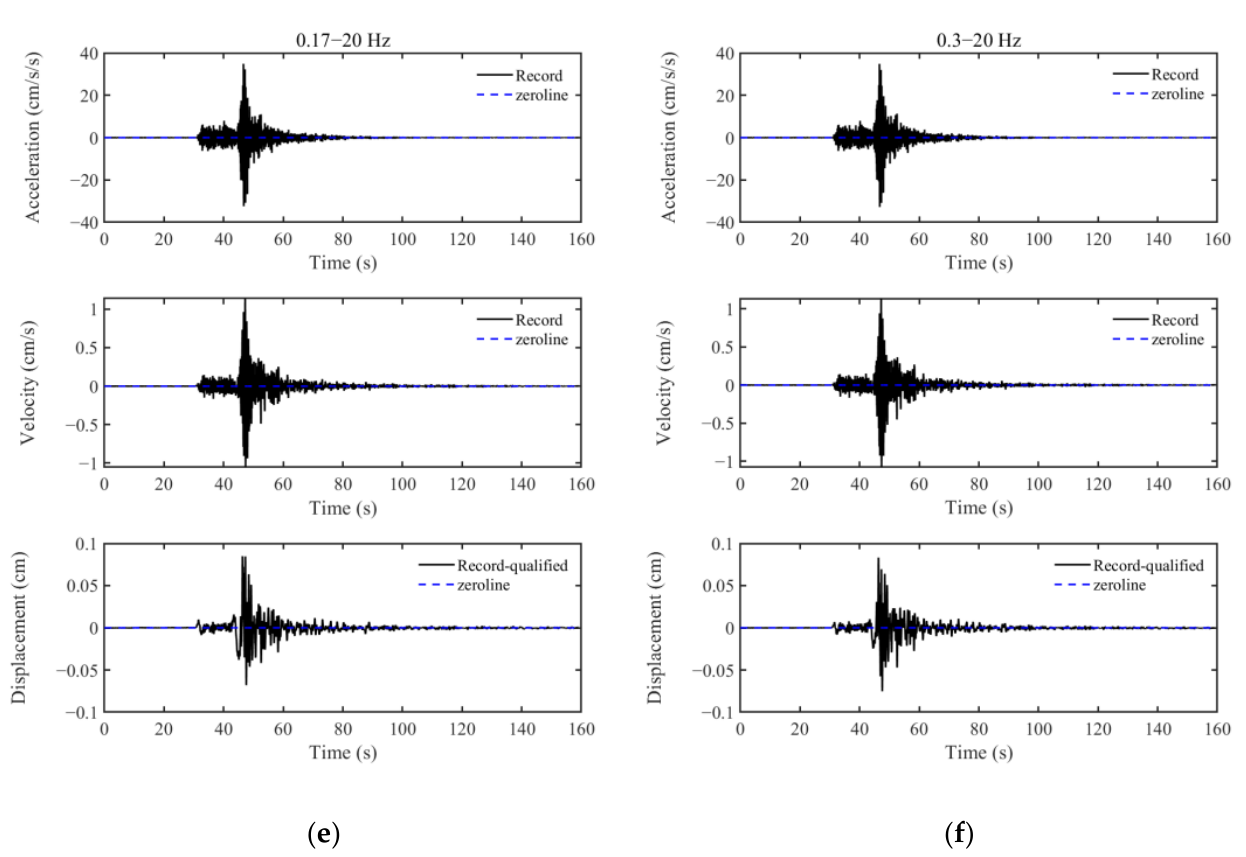
Figure 3. The post-filtering time series curve of record AKBAW--n.0212o88mof.BNE ( d ) and subse- quent images are considered qualified, where figure f is the filtered time series curve using the fre- quency given by CESMD). ( a ) 0.01 Hz; ( b ) 0.05 Hz; ( c ) 0.10 Hz; ( d ) 0.12 Hz; ( e ) 0.17 Hz; ( f )0.30 Hz.